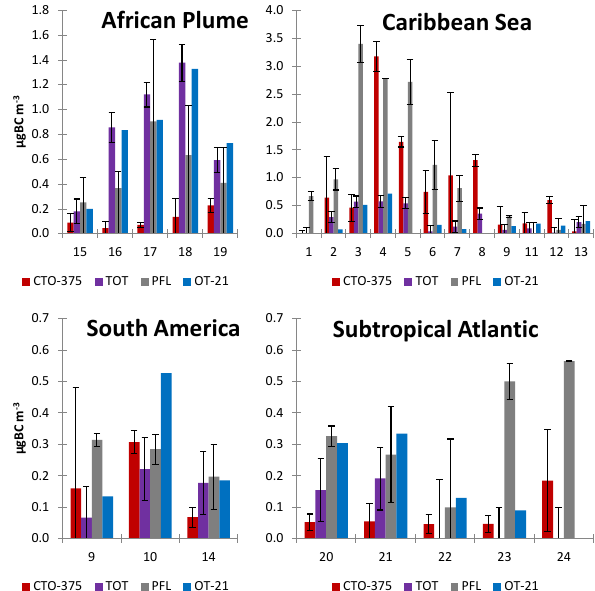
Figure 2. Comparison of black carbon concentrations (µgm − 3 ) from the four selected methods grouped by region with one Fig. 2. Comparison of black carbon concentrations (μg m -3 ) from the four selected 877 standard deviation. Error associated with the OT21 method was methods grouped by region with one standard deviation. Error associated with the OT21 878 ± 0.1µgm − 3 method was ±0.1 µg m -3 . 879